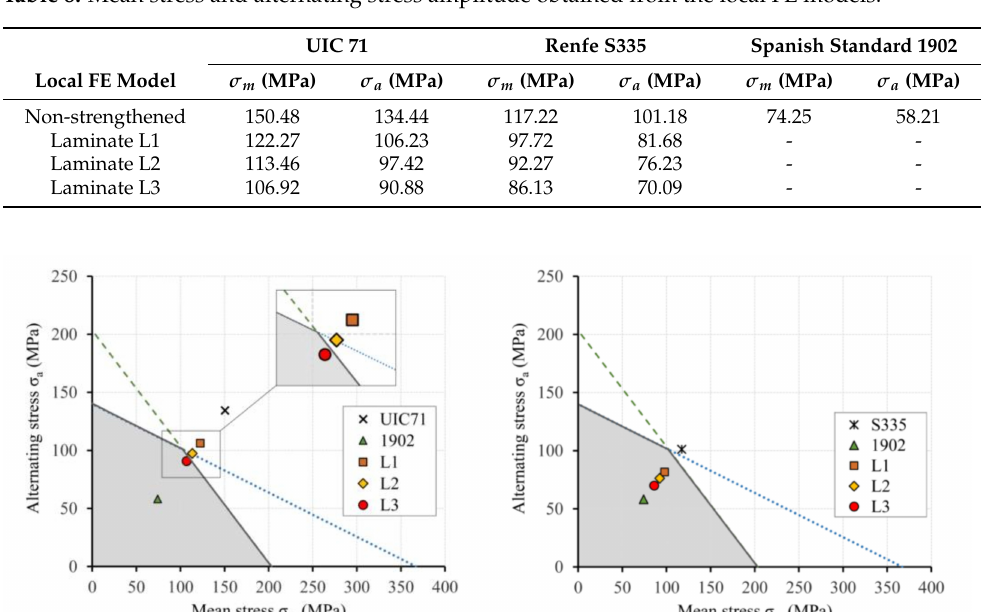
Table 8. Mean stress and alternating stress amplitude obtained from the local FE models.